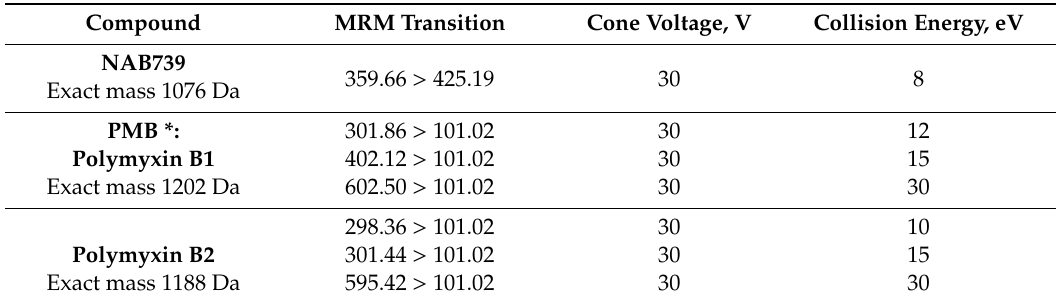
Table 1. Multiple reaction monitoring (MRM) parameters for NAB739 and Polymyxin B.